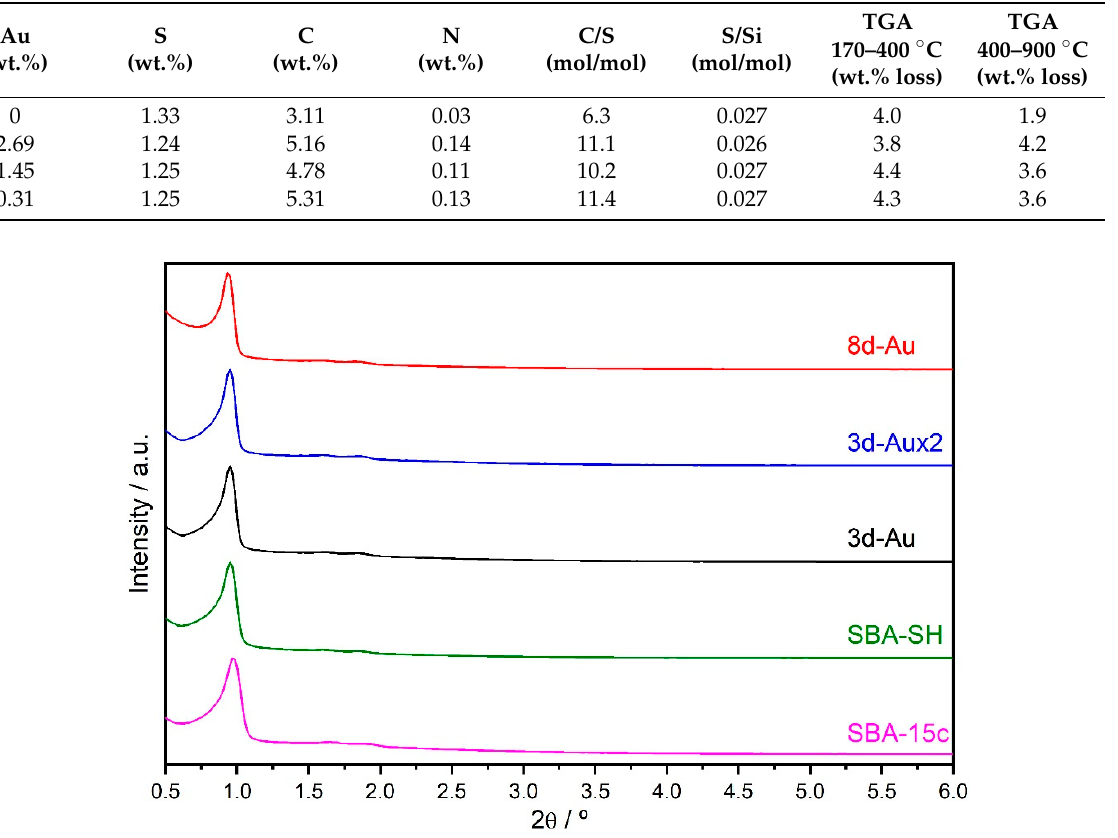
Table 1. Chemical composition and TGA results.